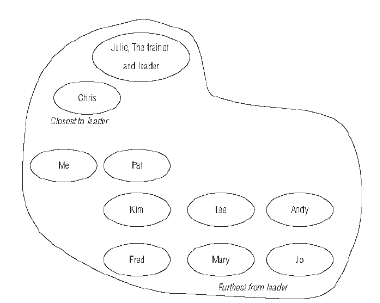
Figure 14: Adapted Group Imago (Hay, 2009 p.173)